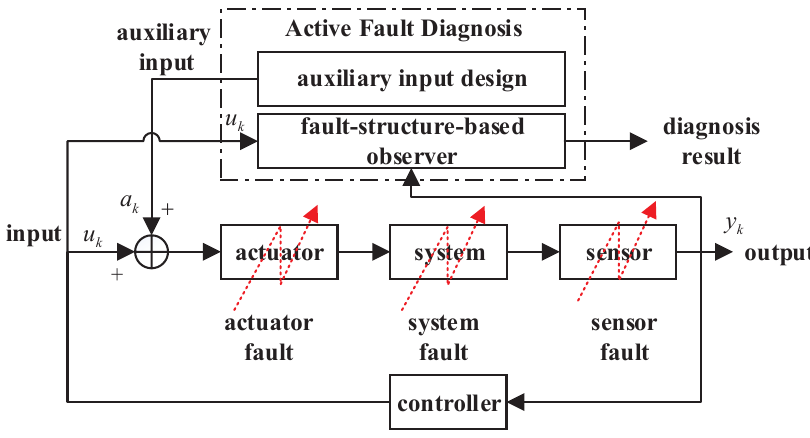
Figure 1. Framework of the fault-structure-based active fault